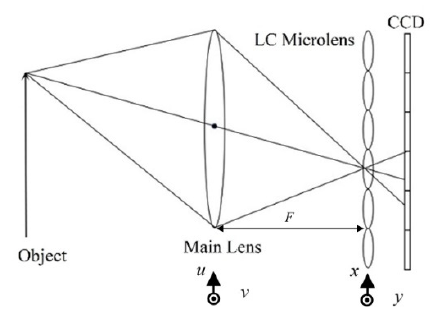
Figure 2. Light field imaging acquisition biplane parameter model based on LC microlens.